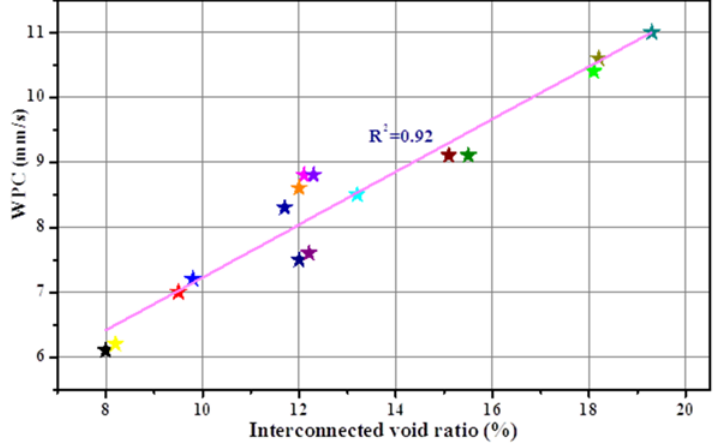
Figure 10. Relationship between interconnected void ratio and WPC of porous mortar and each sample is represented by a colored triangle.